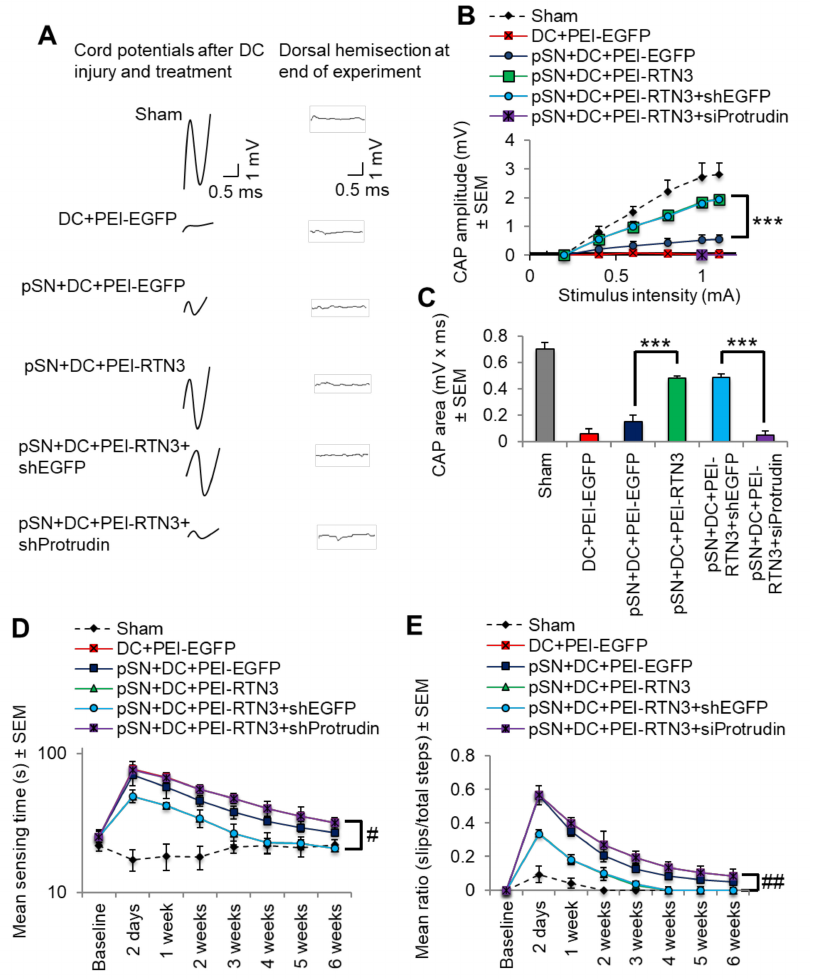
Figure 7. RTN3 overexpression promotes electrophysiological, sensory and locomotor func- tional recovery after DC injury. ( A ) Representative Spike 2 processed CAP traces in sham, DC + PEI-EGFP, pSN + DC + PEI-EGFP, pSN + DC + PEI-RTN3, pSN + DC + PEI-RTN3 + shEGFP ( B ) Negative CAP